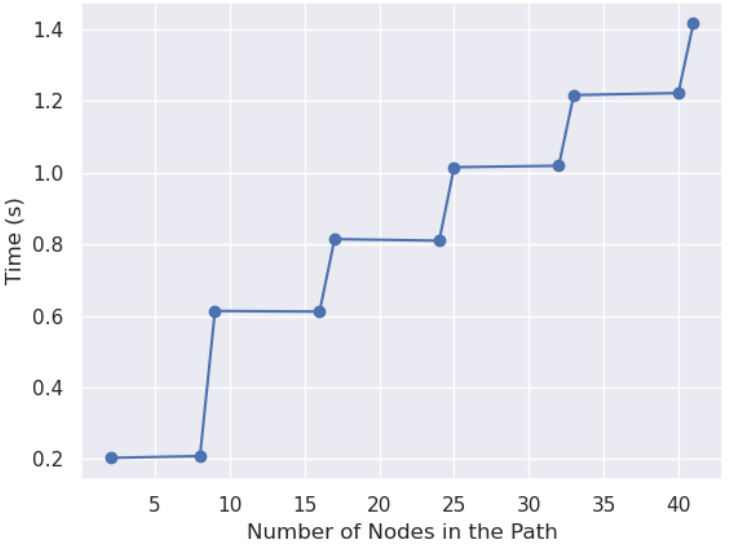
Figure 13. Time taken for path cost